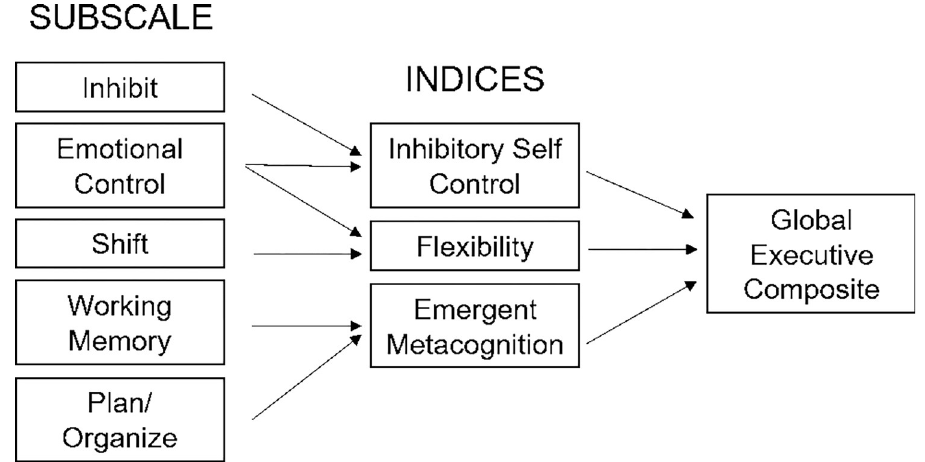
Fig 3. Overview of BRIEF-P standard analysis to quantify executive functions in preschool children, including computation of subscales, indices, and composite score.